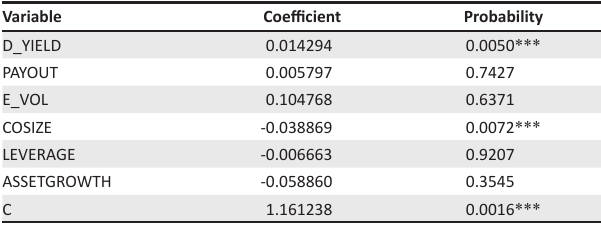
TABLE 6: Random effects model.